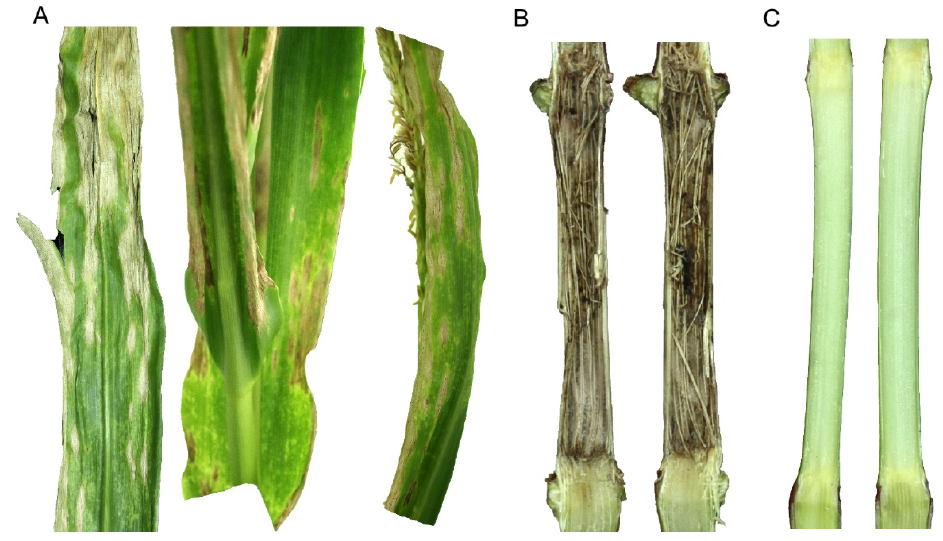
Figure 1. Symptoms caused by Colletotrichum graminicola on the susceptible Zea mays inbred line B73. ( A ) Gray to brown oval necrotic lesions on the B73 leaves are the typical symptom of anthracnose leaf blight. The blight lesions contain dot ‐ like black structures called microsclerotia, which serve as the primary source of inoculum in the next growing season. ( B ) Discoloration of the pith (rotting pith) is the typical symptom of anthracnose stalk rot. The rotten pith also leads to bleaching of the upper part of the maize plants (top dieback). ( C ) Heathy pith.